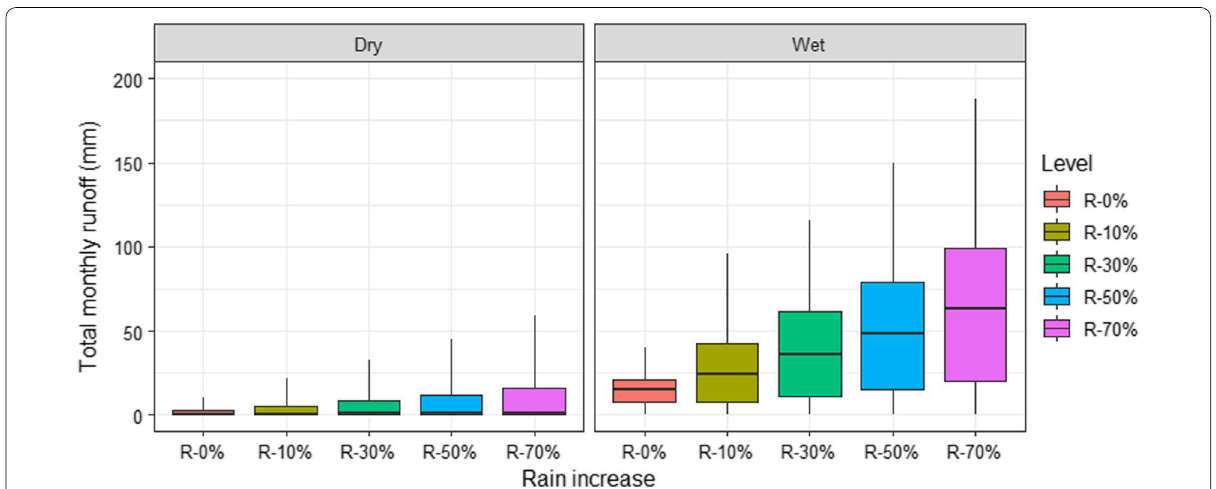
Fig. 12 SWAT simulated monthly runoff from combined, wet, and dry season datasets at varying increased rain level